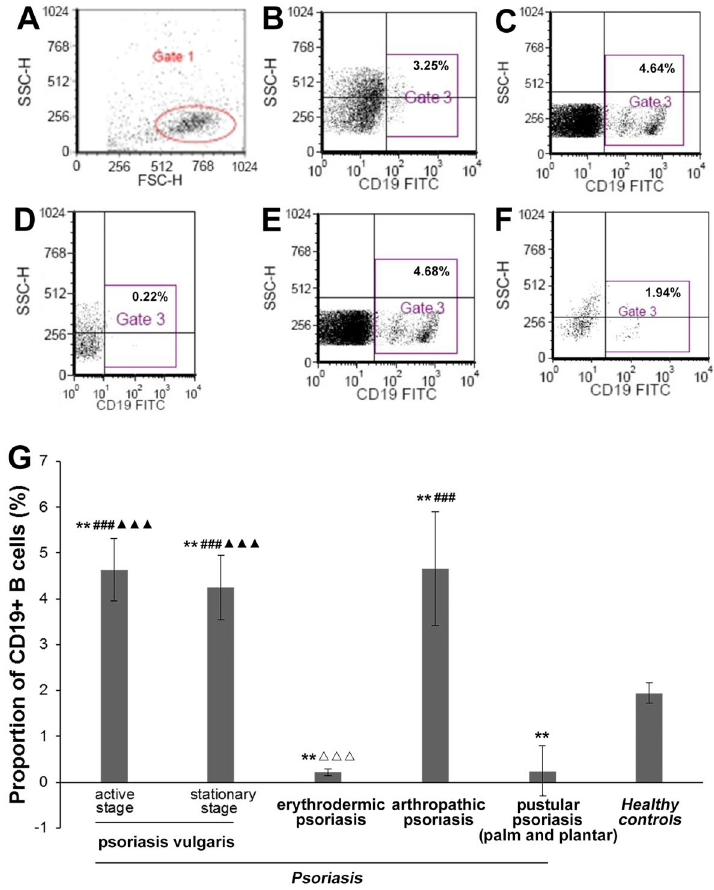
Figure 1. Proportion of CD19 + B cells in periph- eral blood mononuclear cells (PBMCs) from patients with psoriasis and healthy controls, determined by fl ow cytometry. A , total lymphocytes from PBMCs (Gate 1). Proportion of CD19 + B cells (Gate 3) from PBMCs in the healthy controls ( B ), or patients with psoriasis vulgaris ( C ), erythrodermic psoriasis ( D ), arthropathic psoriasis ( E ), and pustular psoriasis (palm and plantar) ( F ). G , proportion of CD19 + B cells are shown as means ± SD (n=33 for psoriasis vulgaris at the active stage; n=32 for psoriasis vulgaris at the stationary stage; n=32 for erythrodermic psoriasis; n=30 for arthropathic psoriasis; n=30 for pustular psoriasis (palmand plantar); n=35for healthy controls). *P o 0.05, **P o 0.01 vs healthy controls; ### P o 0.001 vs pustular psoriasis (palm and plantar); DDD P o 0.001 vs arthropathic psoriasis; mmm P o 0.001 vs erythroder- mic psoriasis (one-way analysis of